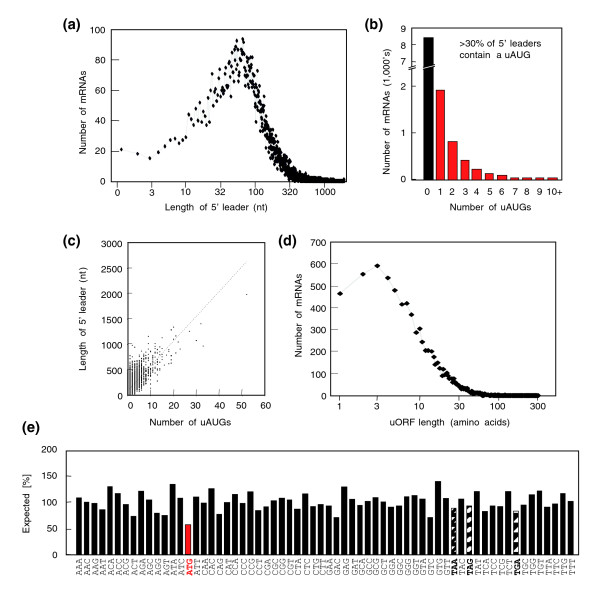
Characterization of Arabidopsis 5' leader sequences. The analysis is based on a set of sequences obtained from cap-purified mRNAs (see Materials and methods). (a) Length distribution. (b) Number of uAUGs. (c) Correlation between length of the leader and number of uAUGs. (d) Distribution of uORF lengths among the 12,129 bona fide full-length leader sequences. uORFs that overlap the main ORF were not included in this analysis. (e) The frequency of each dinucleotide (AA, AC, and so on) was determined empiricially across all 5' leaders (not shown). Then, the theoretical frequency of each triplet was predicted based on the dinucleotide data (see Materials and methods for details) and set to 100%. The empirical frequency of each triplet across all 5' leaders was then expressed in relation to the predicted frequency.